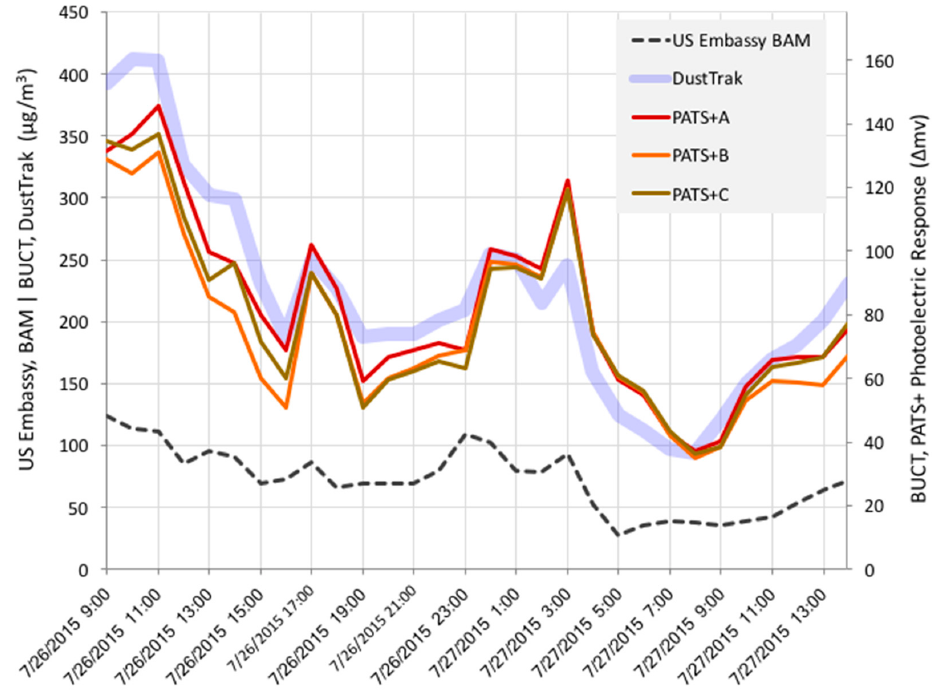
Figure 3. Hourly average trace of responses from (1) co-located PATS+ units (change in mV from the photoelectric chamber), (2) a DustTrak ( μ g/m 3 , uncorrected PM 2.5 ) near Beijing University of Chemical Technology (BUCT), and (3) the US Embassy BAM ( μ g/m 3 , PM 2.5 ) located approximately four kilometers away.